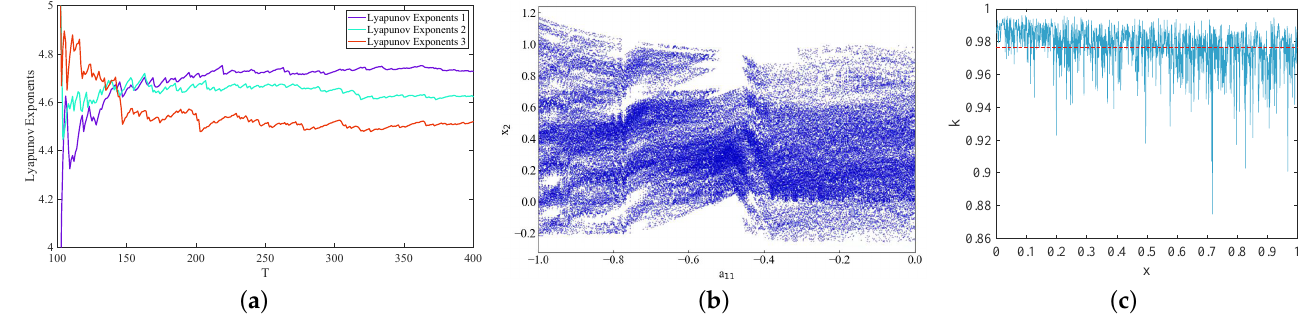
Figure 1. The chaos performance of non-degenerate chaotic maps: ( a ) Lyapunov exponent; ( b ) Bifur- cation diagrams; ( c ) The 0–1 Gottwald-Melbourne